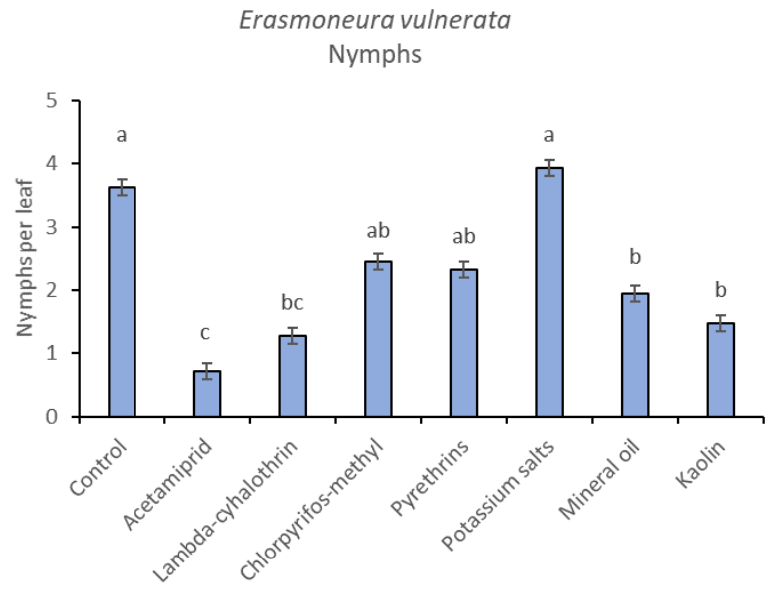
Figure 7. Least-square means (±std. err.) of Erasmoneura vulnerata nymphs observed on different treatments in the 2018 trial. Different letters indicate significant differences at t -test ( α = 0.05).